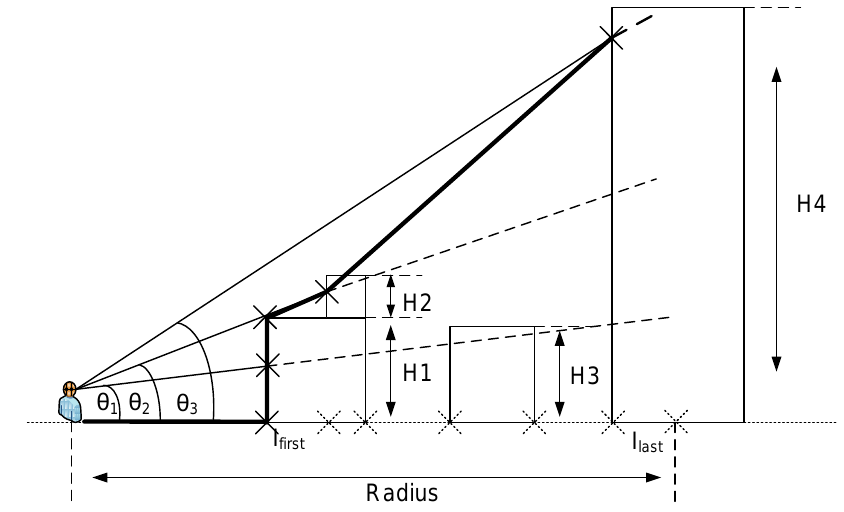
Figure 7. Search Algorithm 1 determining sight line intersections in a true 3D environment. The thick black line outlines the final query boundary shape of the 3D Isovist dome in this direction.